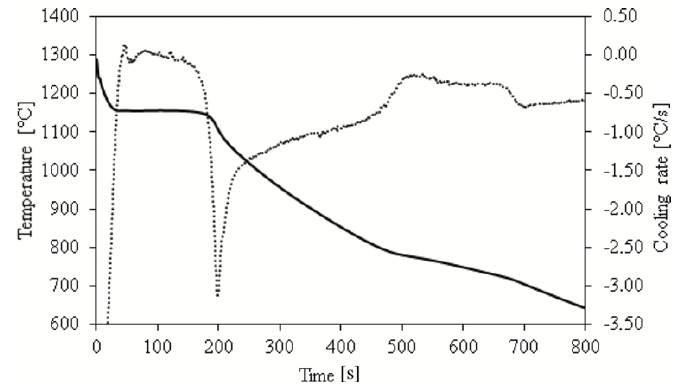
Figure 3. Cooling curve (solid line) and its first derivative (dotted line) of the solution strengthened ferritic ductile iron studied in this work.